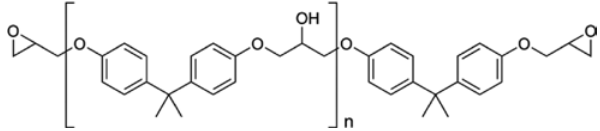
Figure 1: The molecular structure of epoxy resin based on bisphenol